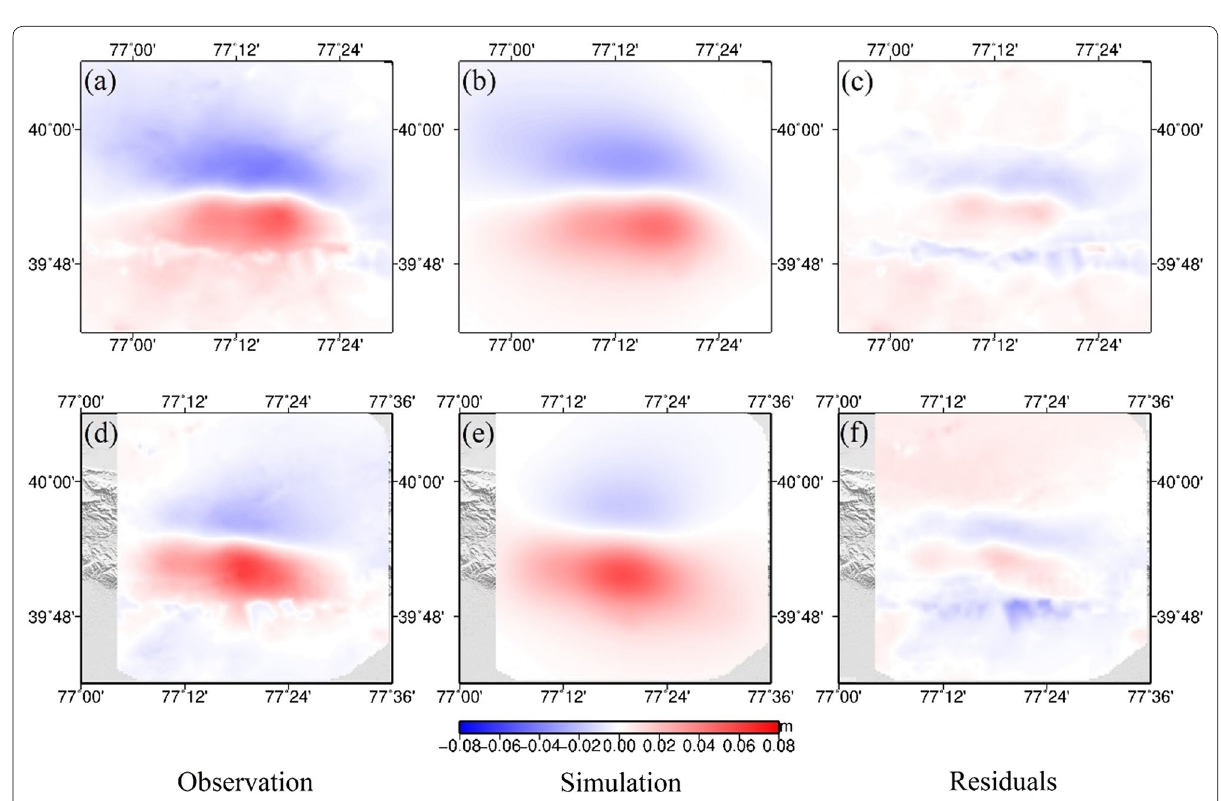
Fig. 4 Observation, simulation and residual from ascending ( a – c ) and descending ( d – f ) InSAR data and